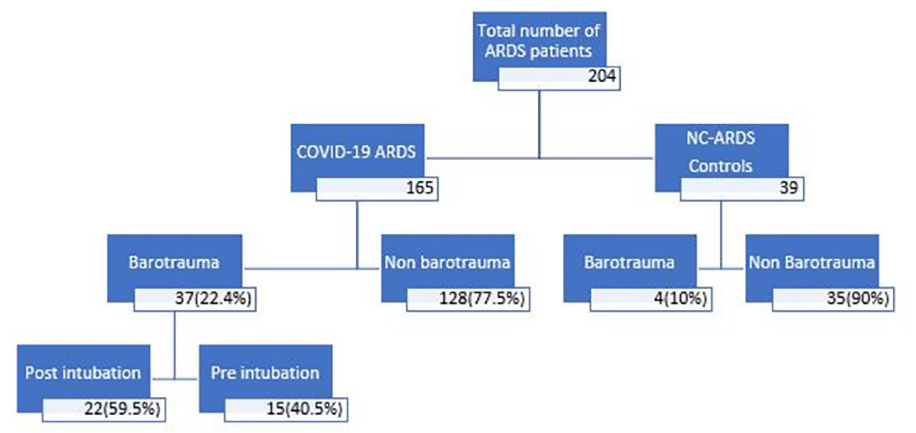
Fig 1. Flow chart of patients admitted for COVID -19 ARDS with control arm. https://doi.org/10.1371/journal.pone.0282735.g001 (41% vs. 61%, respectively, p = 0.03), and had lower body mass index (BMI, 38.9 ± 12.8 vs. 33.3 ± 8.4 kg/m 2 , respectively, p = 0.01). Patients with COVID-19 had increased rates of hyper- tension (59% vs. 83%, p < 0.01) and were less likely to be current smokers (35.9% vs.4.8%, p < 0.01) compared to historic controls. Approximately one-third of patients had the comorbid chronic obstructive pulmonary disease (COPD) in the COVID-19 group which was similar to the control group. Historic ARDS control patients were sicker with higher mean SOFA score Table 1. Demographics and baseline characteristics of patients with COVID-19 compared to controls.